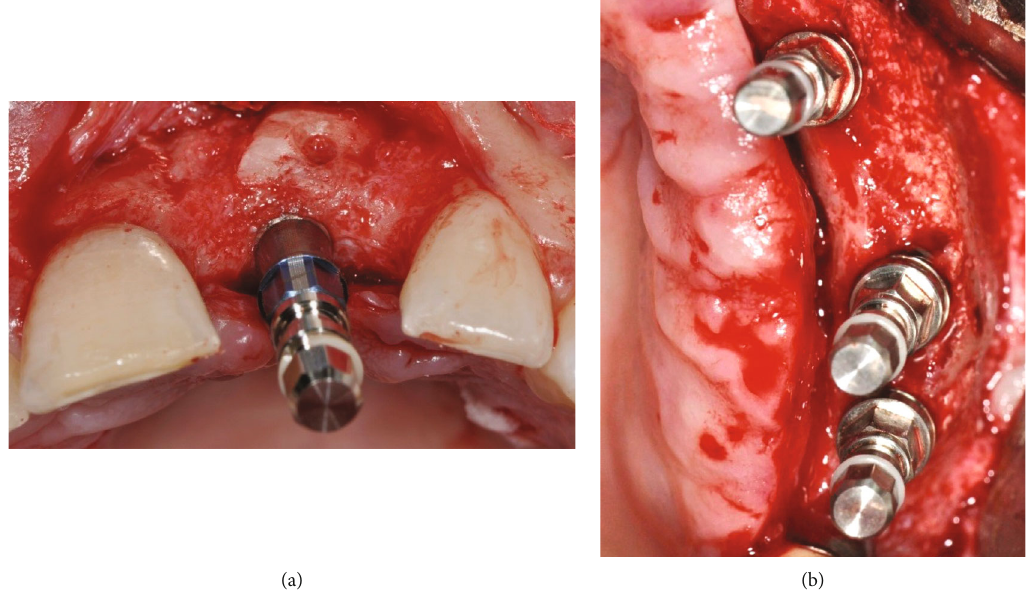
Figure 7: Implant placement in the grafted sites: (a) case no. 1; (b) case no.